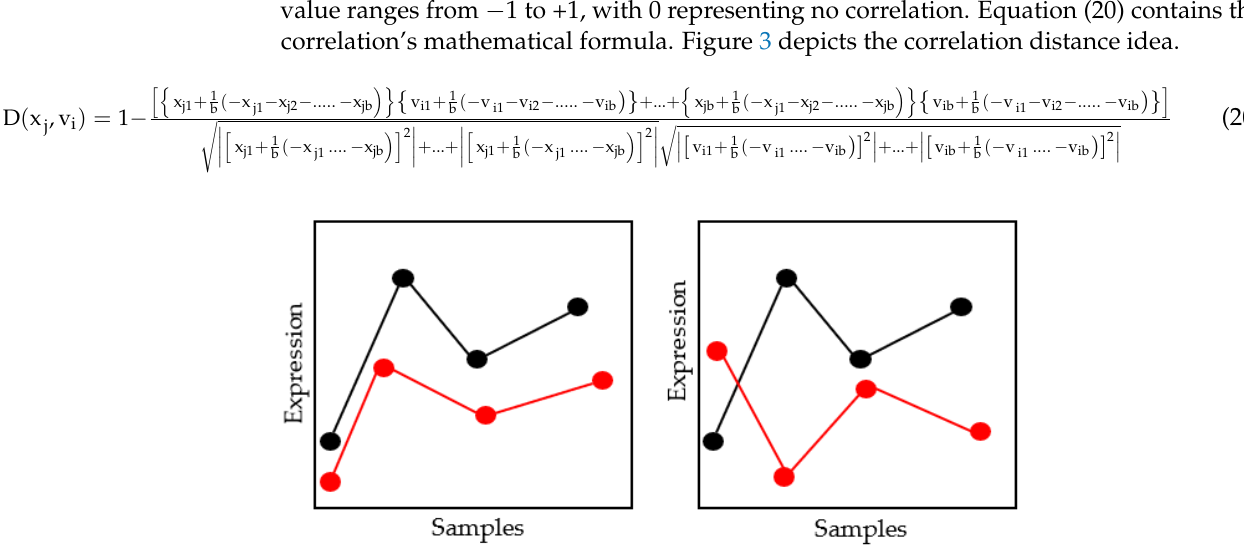
(21) Figure 4. Schematic Diagram of Cosine Distance Measures. 2.2.6. Euclidean Two points in Euclidean space are separated by the Euclidean distance [30]. It computes the square root of the value difference between parallel data points as the sum of squares. Equation (22) contains the equation for Euclidean distance measures. N